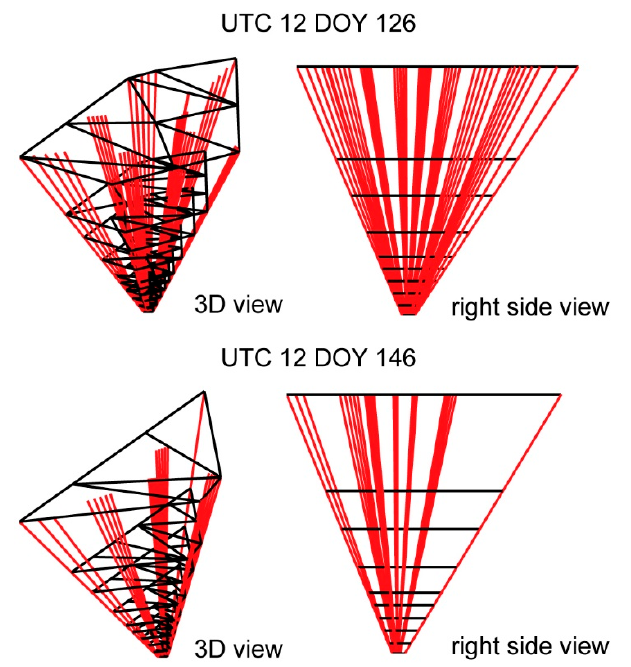
Figure 10. The tomographic area (all black loops), tomographic nodes (triangles vertices) and distribution of GNSS signals (red lines) at UTC 12 on DOY 126 (top) and DOY 146 (bottom).